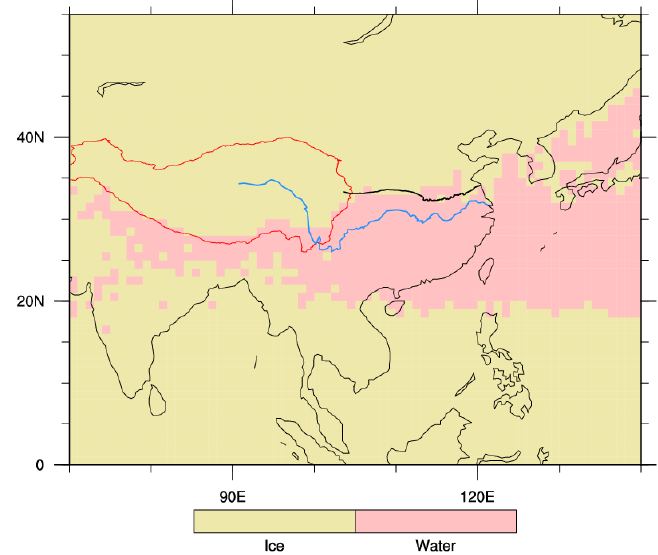
Figure 7. Annual horizontal distribution of the prevailing cloud phase. The red solid line is the Qinghai – Tibet Plateau, the blue solid line is the Yangtze River, and the black thick solid line is the Qinling Mountain and Huaihe river.